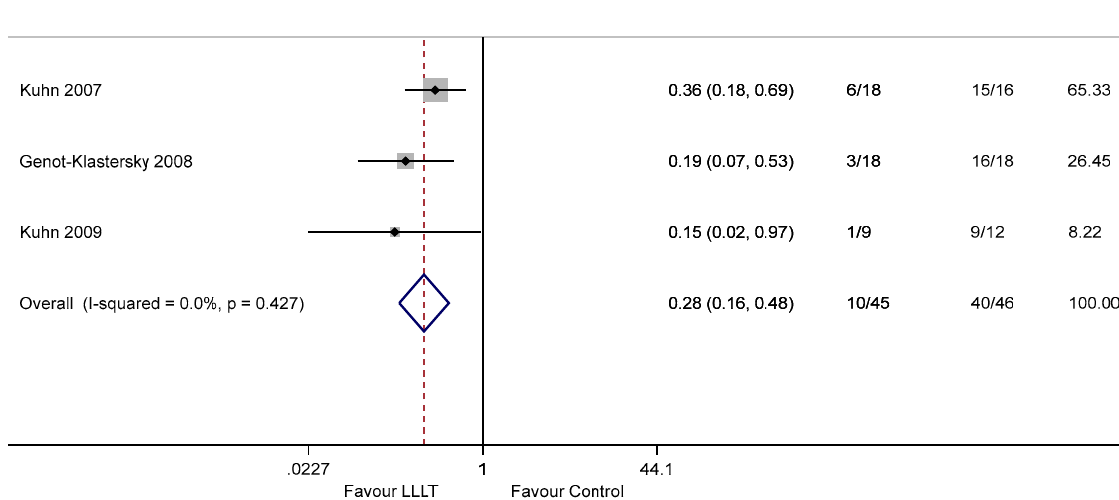
Figure 4. The sensitivity analysis forest plot illustrating the pooled estimate of PBM in reducing the severity of OM.